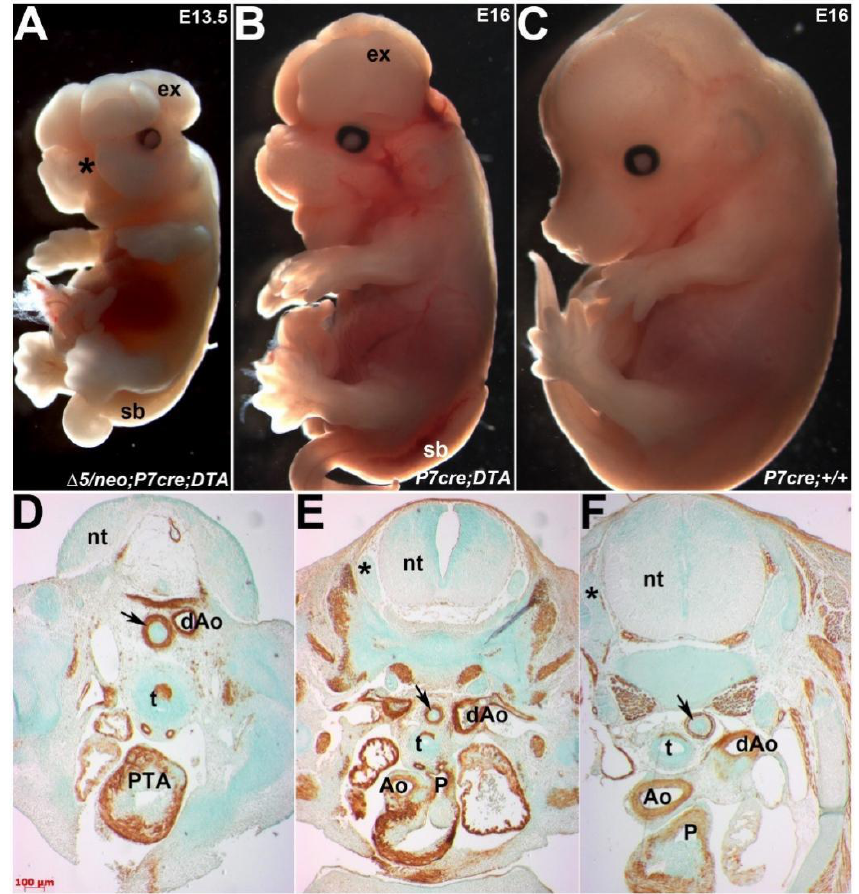
Figure 7. Genetic cell ablation of Pax7 lineage in only Pax3 ∆ 5/neo mutants results in congenital heart defects. ( A – C ) Gross phenotypes following Cre/loxP-mediated genetic cell ablation in E13.5 Pax3 ∆ 5/neo / Pax7 Cre /R26 -EGFP-DTA ( A ), E16 Pax7 Cre /R26 -EGFP-DTA ( B ) compared to E16 Pax3 ∆ 5/neo non-DTA control ( C ). As all Pax3 ∆ 5/neo / Pax7 Cre /R26 -EGFP-DTA ablation mutants die by E15.5, we examined only viable E13.5 embryos. Note Pax7 Cre -mediated ablation in both Pax3 ∆ 5/neo mutant and control backgrounds causes exencephaly (ex), spina bifida (sb), but that mid-face clefting (* in A ) is only present in Pax3 ∆ 5/neo ablation mutants. As expected, presence of Pax7 Cre alone ( C ) does not cause any abnormalities. ( D – F ) IHC using αSmooth muscle actin revealed enhanced muscular hypoplasia in Pax3 ∆ 5/neo mutants ( D ) and that only Pax7 Cre mediated cell ablation results lack of outflow tract septation in Pax3 ∆ 5/neo ablation mutants ( D ) but not Pax7Cre ablation mutants ( E ). Note Pax7 lineage-ablated Pax3 +/neo hearts only have a single abnormal PTA exiting the right ventricle ( D ) but Pax7 lineage-ablated controls have unaffected hearts with separate aorta (Ao) and pulmonary trunks (p) exiting the heart. Additionally, note that the DRGs (* in E ) are intact in Pax7 lineage-ablated controls and wildtype (* in F ) but are absent in Pax7 lineage-ablated Pax3 +/neo mutants ( D ). Small arrows in ( D – F ) indicate similar planes through the esophagus. Abbreviations: nt, neural tube; dAo, descending aorta. Scale ( D – F ), 100 μm.